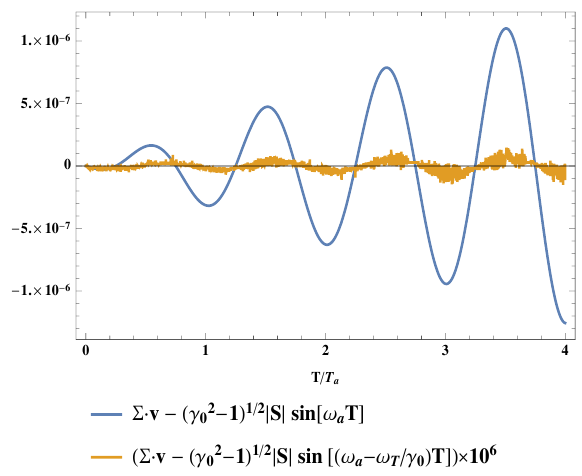
Figure 1 . We have solved numerically the equations of motion eqs. (5.34){(5.35) and then evaluated (cid:6) (cid:1) v , from eq. (5.36), on the solution. We show that the sinusoidal behavior with frequency ! a (cid:0) ! T =(cid:13) 0 has the correct behavior, modulo tiny higher order e(cid:11)ects. We have set realistic values of a and ! T and an initial condition (cid:13) ( T = 0) (cid:17) (cid:13) 0 = 29 : 3. Here T a (cid:17) 2 (cid:25)=! a . Note that also (cid:13) is constant at linear order in ! T , and so the only time-dependent part of E in eq. (4.8) is due to (cid:6) (cid:1) v